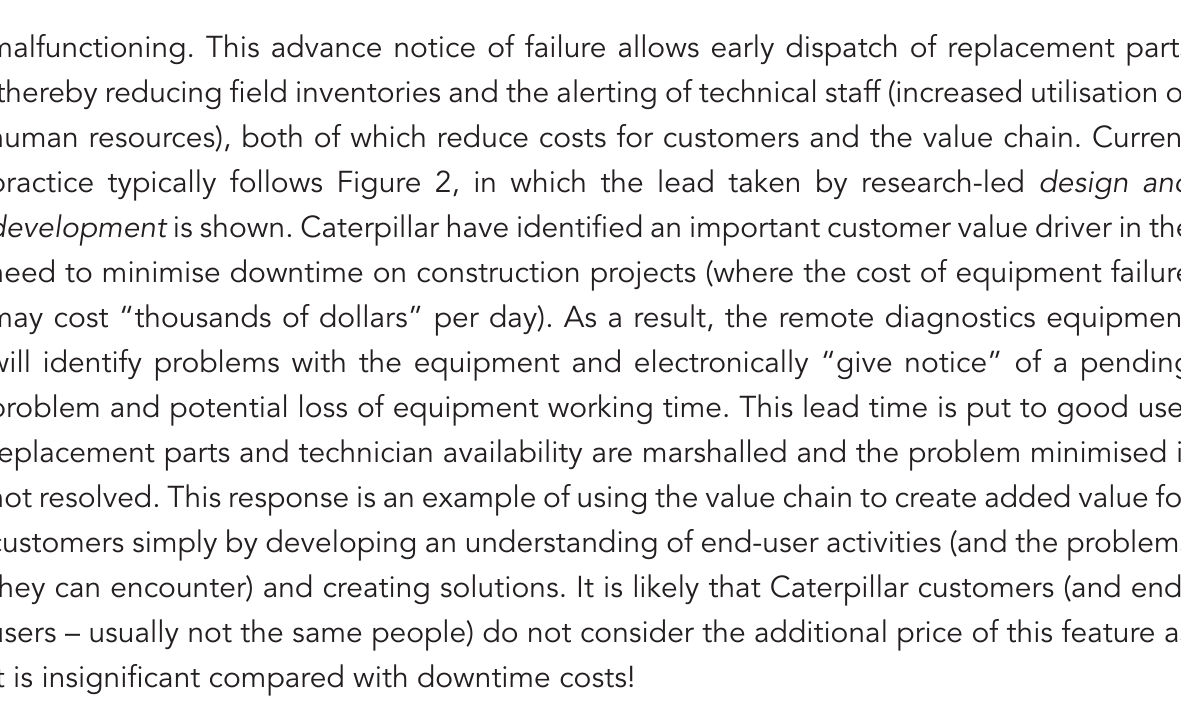
Who "owns and manages" the processes and activities is a function of strategic effectiveness and operational efficiency